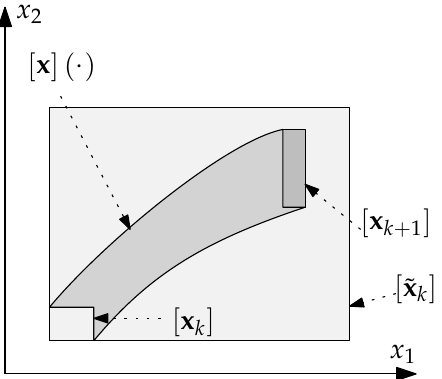
Figure 7. Guaranteed integration by Lohner’s algorithm [36].